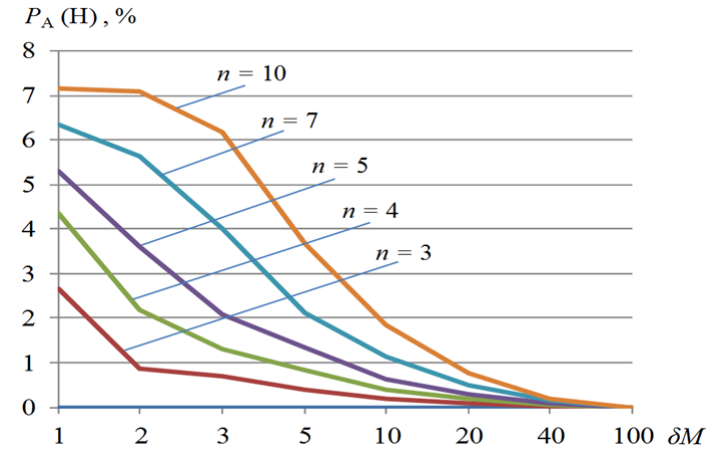
Figure 3. Parameter P dependence to M and n for Hamilton A